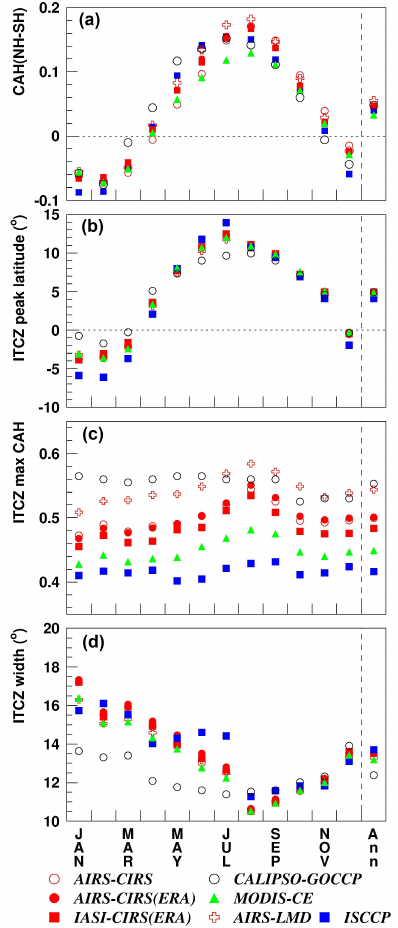
Figure 11. Seasonal cycle/annual average of (a) CAH differences between NH (0–60 ◦ N) and SH (0–60 ◦ S), (b) ITCZ peak latitude, (c) maximum CAH within ITCZ and (d) width of